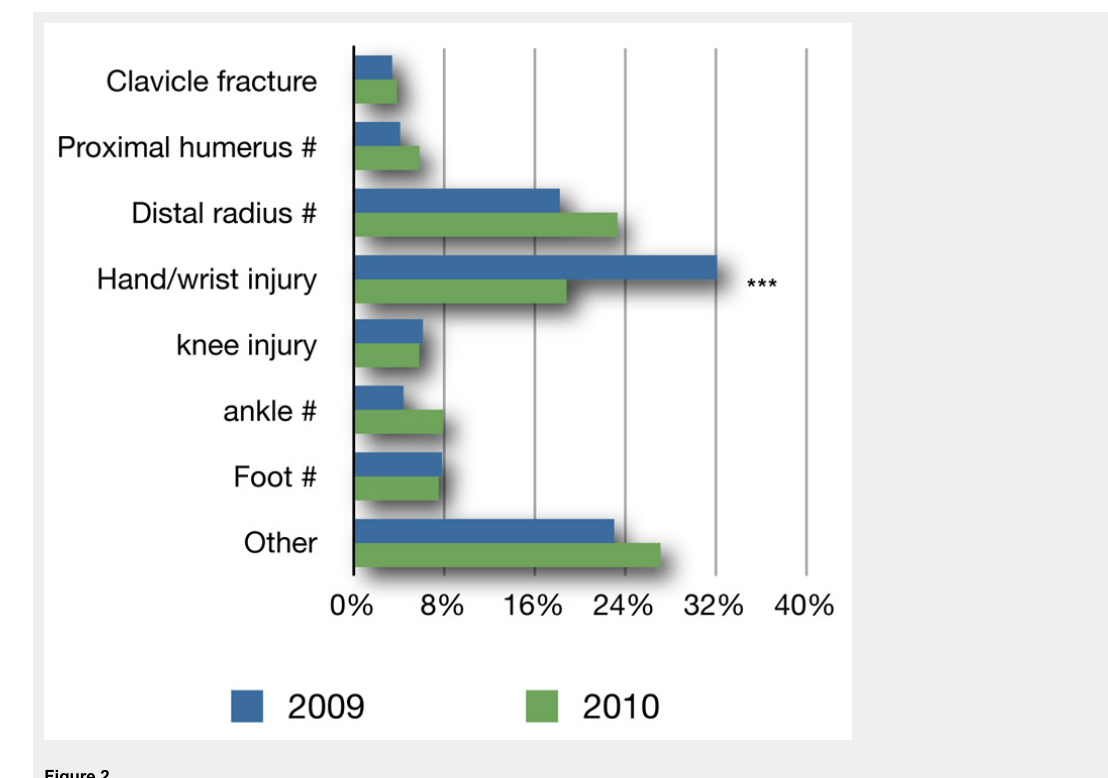
The 2009 & 2010 cohorts were case mix matched except for ‘hand / wrist injuries’. [*** = extremely significant, (p <0.001)].